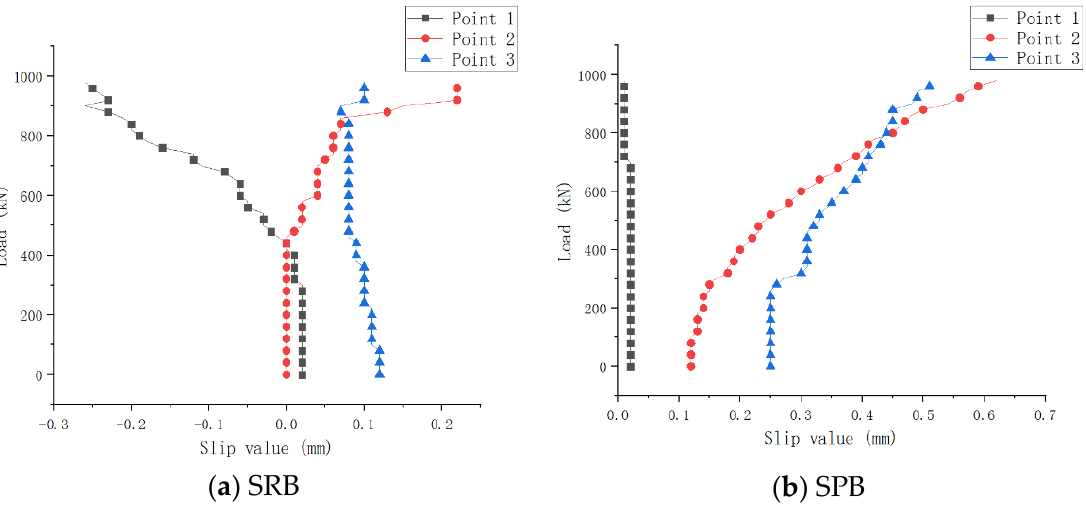
Figure 10. Variation curves of load-interface slip deformation. After prestressing, each measuring point’s slip value was set as the initial slip value.